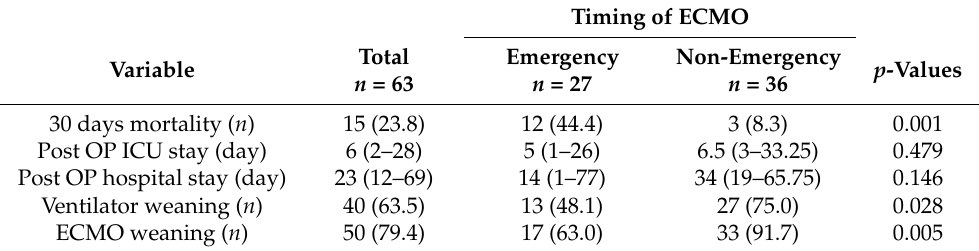
Table 2. Primary clinical outcome.